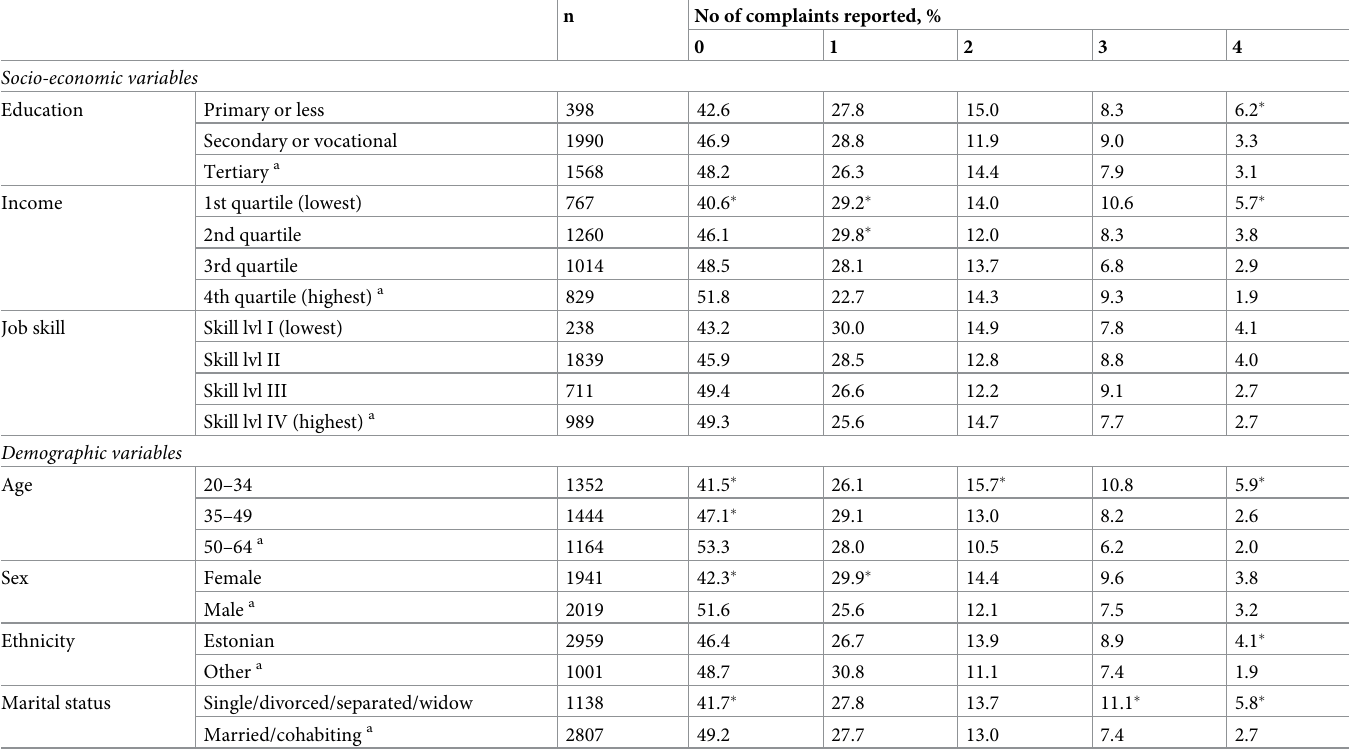
Table 5. Distribution of reported co-existing mental health complaints by socio-economic and demographic